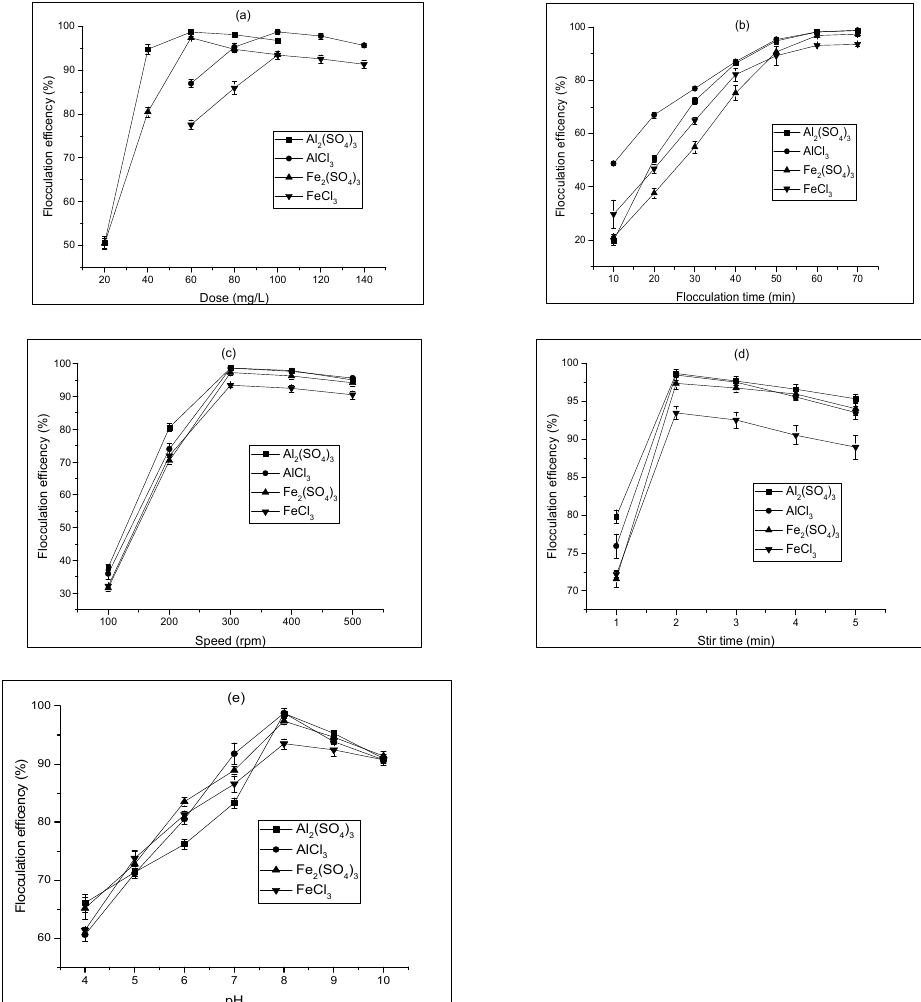
Figure 2. ( a ) Flocculation efficiency of different doses of flocculants. Condition: stirring for 2 min at 300 r/min, pH 8.0, settled for 70 min. ( b ) Flocculation efficiency at different settlement times. Condition: stirring for 2 min at 300 r/min, pH 8.0, 60 mg/L sulfate and 100 mg/L chloride. ( c ) Flocculation efficiency at different stirring speeds. Condition: stirring for 2 min at pH 8.0, settled for 60 min, 60 mg/L sulfate and 100 mg/L chloride. ( d ) Flocculation efficiency at different stirring times. Condition: stirring 300 r/min, pH 8.0, settled for 60 min, 60 mg/L sulfate and 100 mg/L chloride. ( e ) Flocculation efficiency at different pH values. Condition: stirring for 2 min at 300 r/min, settled for 60 min, 60 mg/L sulfate and 100 mg/L chloride. Data are reported with +/ − SD, and n = 3. Maximum harvesting efficiencies of 98.73 ± 0.49% and 97.43 ± 0.42% were achieved using 60 mg/L sulfates (Al 2 (SO 4 ) 3 and Fe 2 (SO 4 ) 3 ), respectively, whereas flocculation effi- ciencies of 98.77 ± 0.64% and 93.50 ± 0.96% were attained using 100 mg/L AlCl 3 and FeCl 3 , respectively. The optimum dose of sulfates (60 mg/L Al 2 (SO 4 ) 3 and Fe 2 (SO 4 ) 3 ) was rela- tively lower than the optimum dose of chlorides (100 mg/L AlCl 3 and FeCl 3 ). Similar find- ings have been reported by Reyes and Labra [11], who demonstrated that a low dose of sulfate (1.5 g/L Al 2 (SO 4 ) 3 ) and a high dose of chloride (7.0 g/L FeCl 3 ) resulted in Scenedes- mus sp. flocculation efficiency of 99.4% and 98.4%, respectively. However, some research- ers have reported that the flocculation efficiency of low-dose chlorides is comparable to